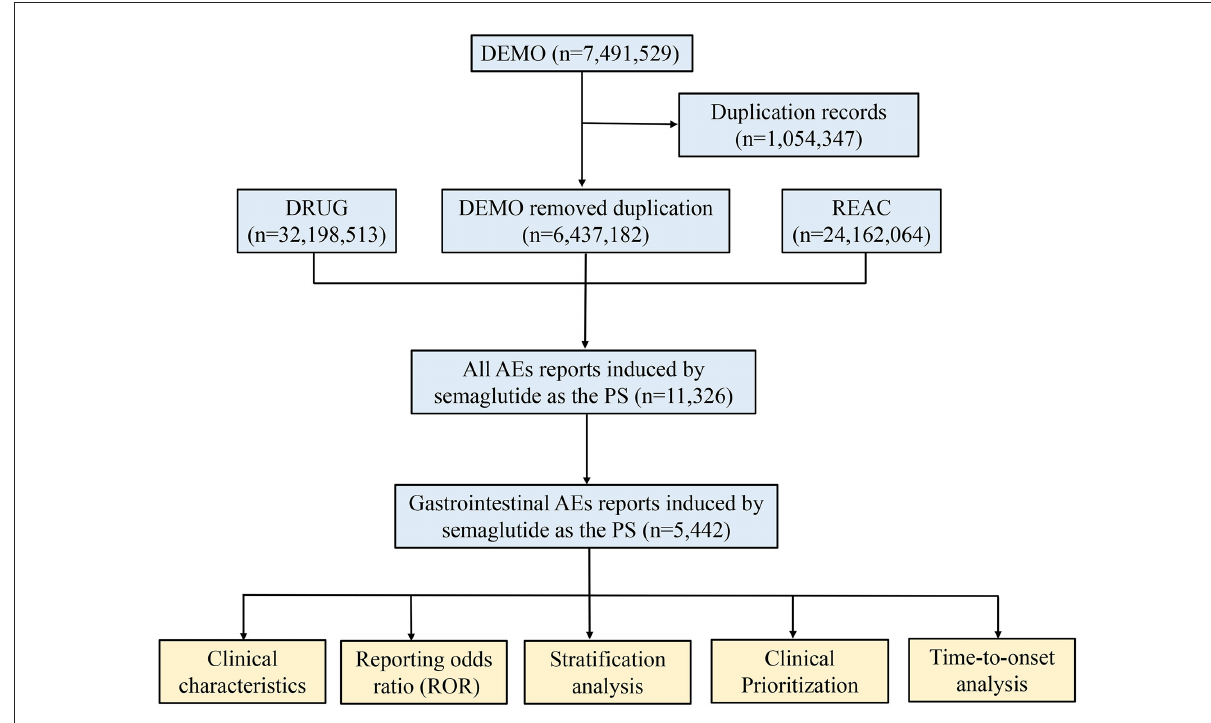
FIGURE1 The process of selecting semaglutide-associated gastrointestinal adverse events from food and drug administration adverse event reporting database.